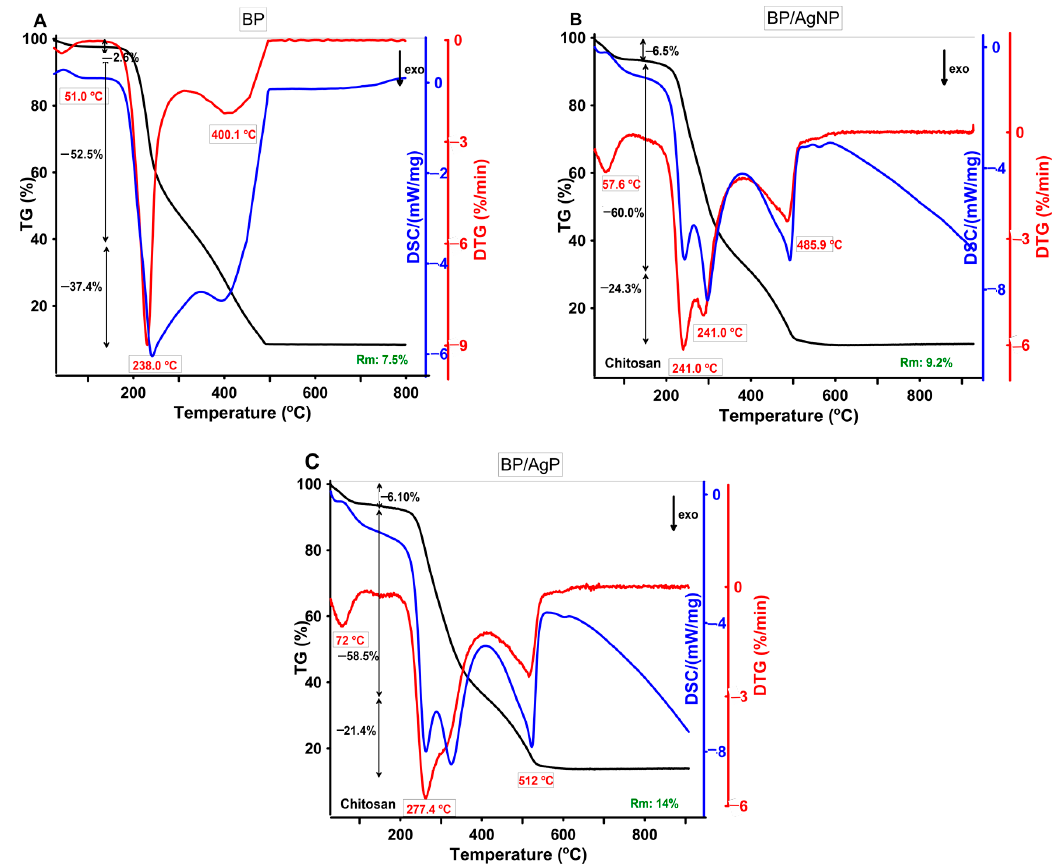
Figure 12. Thermogravimetry (TG), Differential thermogravimetry (DTG), and Differential Scanning Calorimetry (DSC) curves of BP ( A ), BP/AgNP ( B ) and BP/AgP ( C ) measured in the air atmosphere.